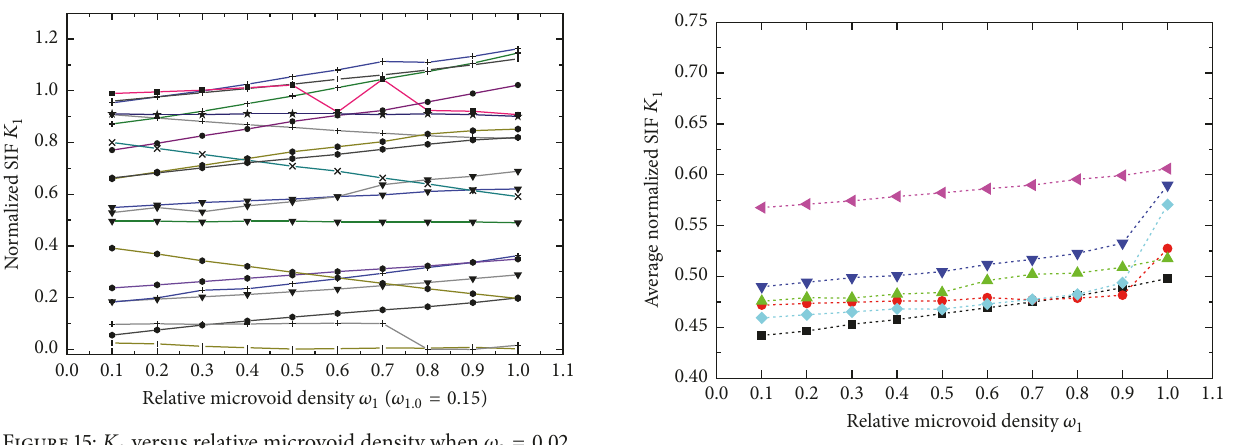
Figure 15: 𝐾 1 versus relative microvoid density when 𝜔 2 = 0.02.